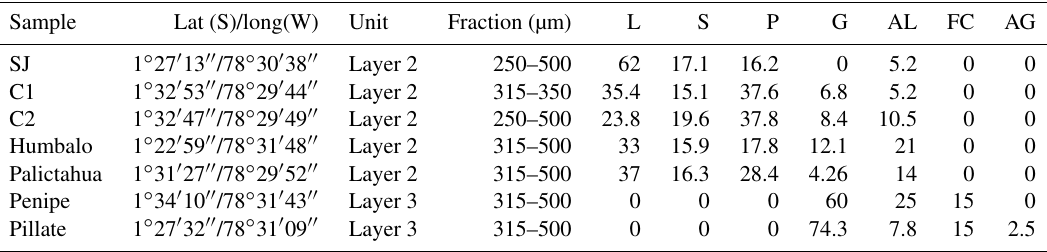
Table 2. Componentry results of tephra